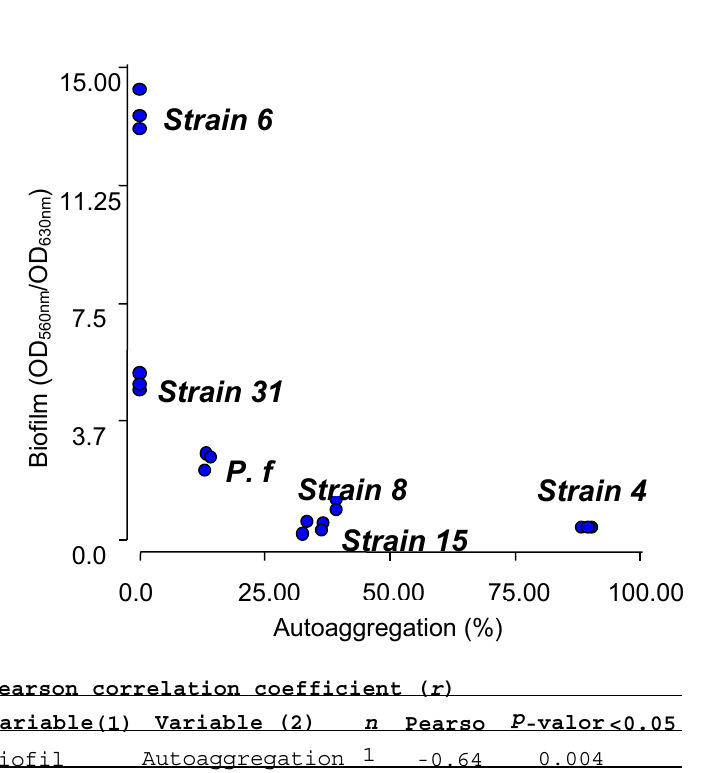
Figure 7. Scatter plot of two variables: biofilm formation ability (OD 560nm /OD 630nm ) and autoaggregation (%). The Pearson correlation coefficient ( r ) was calculated using Infostat, version 1.0.